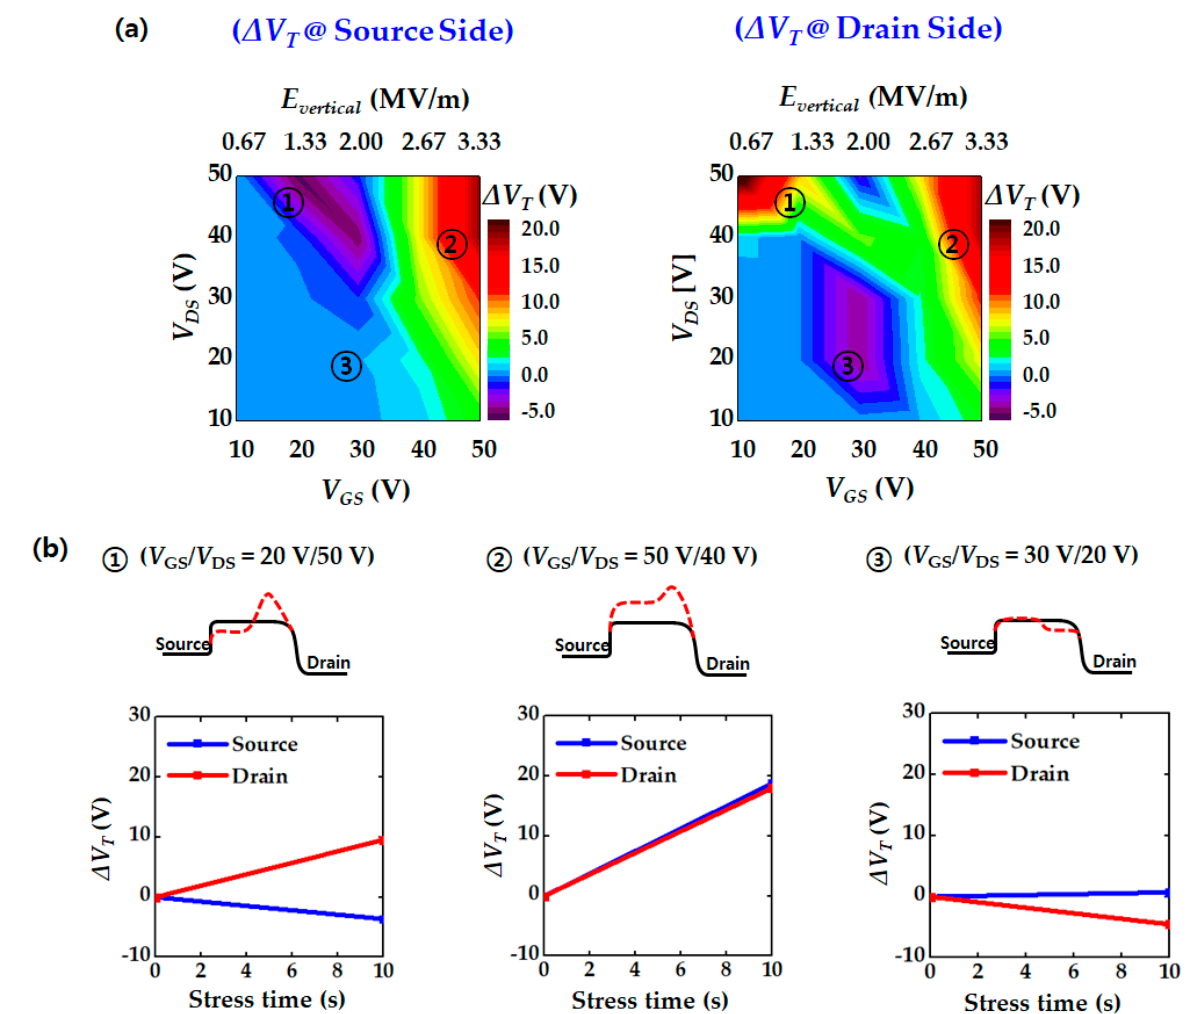
Figure 4. V T shift results after various stress bias (O-poor device case): ( a ) Contour maps of V T shift at source and drain side (forward and reverse read-out); ( b ) V T change as a function of stress time at three major bias regions with schematic illustration of barrier height modulation.